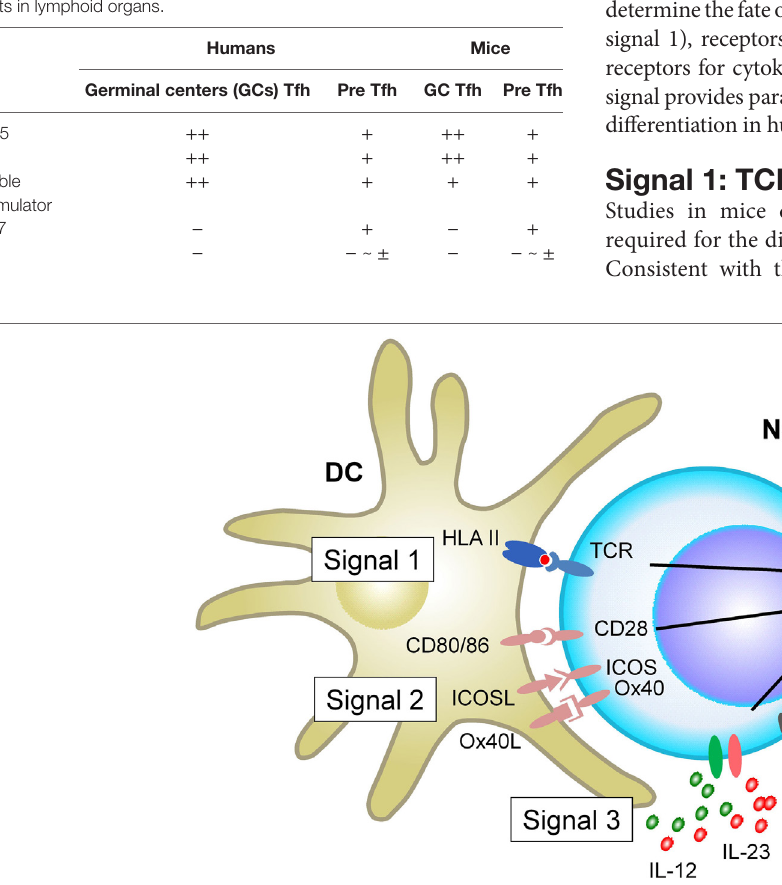
FigURe 1 | Factors that positively regulate human T follicular helper (Tfh) cell differentiation. When interacting with antigen-presenting dendritic cells (DCs), naïve CD4 + T cells receive signals via three major receptor families: the T cell receptor (TCR, signal 1), receptors for co-stimulatory molecules (signal 2), and receptors for cytokines (signal 3). For signal 1, evidence in both mice and humans shows that strong TCR signals promote Tfh cell differentiation. For signal 2, in addition to CD28 signals which is essential for optimal T cell activation, signals via inducible co-stimulator and Ox40 promote human naïve CD4 + T cells to express multiple Tfh molecules. For Signal 3, among inflammatory cytokines that activated DCs produce, IL-12 and IL-23 play dominant roles for human naïve CD4 + T cells to express Tfh molecules. The effect of IL-12 and IL-23 is further enhanced by the co-presence of TGF- β family molecules, TGF- β and Activin A. Given that TGF- β and Activin A are often highly expressed in human inflamed tissues, the source of these cytokines might be both from interacting DCs and from microenvironment.